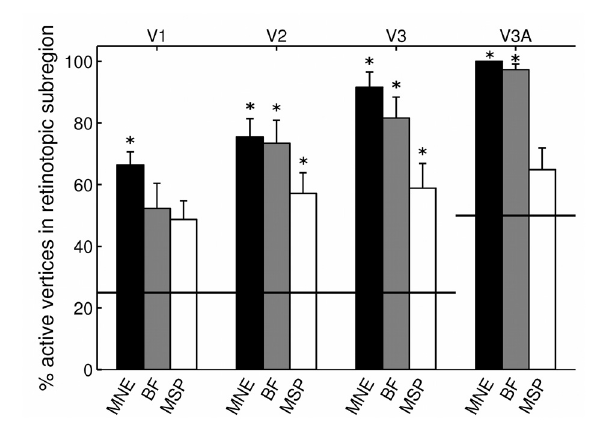
FIGURE 3 | Source localization accuracy of evoked responses to quadrant stimuli, reconstructed with minimum norm estimate (MNE, black), beamformer (BF, gray), and multiple sparse priors (MSP, white). Bars show percentage of active vertices localized to the fMRI-defined subregion of each of four early visual areas (V1, V2, V3, and V3A). Error bars show s.e.m. Black lines indicate chance accuracy level for each early visual area ROI. ∗ indicates p m < 0 . 0031 for Wilcoxon signrank test of localization accuracy compared to chance ( p i < 0 . 05 with Bonferroni correction for 16 multiple comparisons).